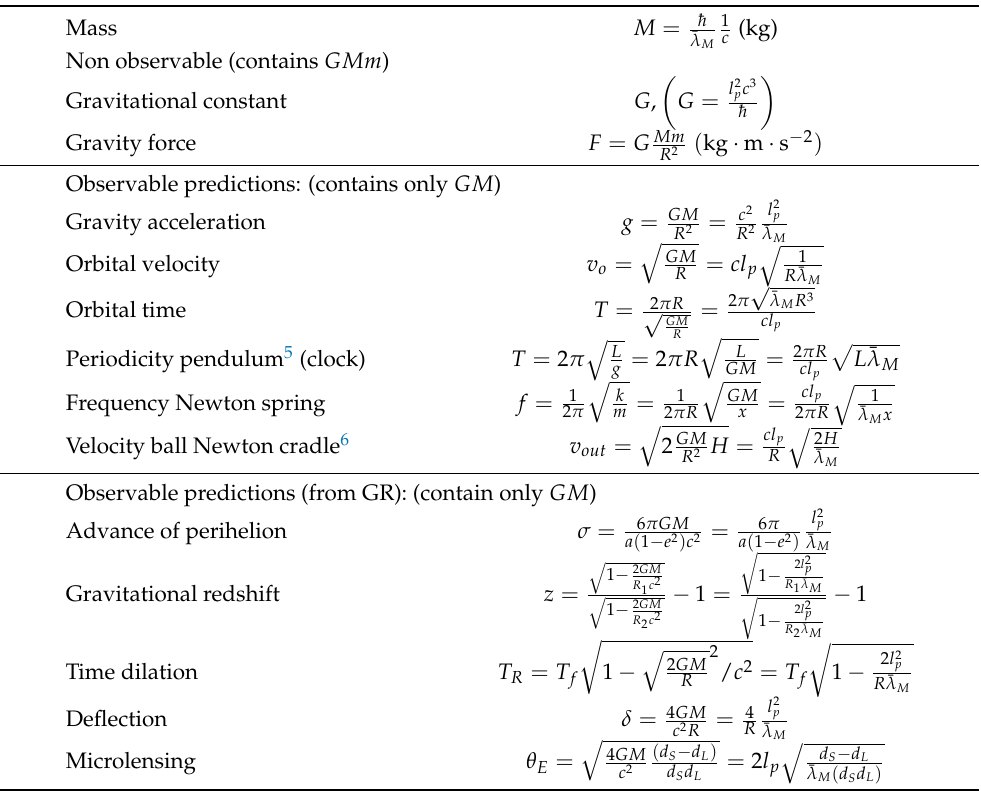
Table 4. The table shows that any observable gravity phenomena contains GM and not GMm and, further, that when assuming G is a composite, then we end up being able to predict all observable gravity phenomena only from l p and c